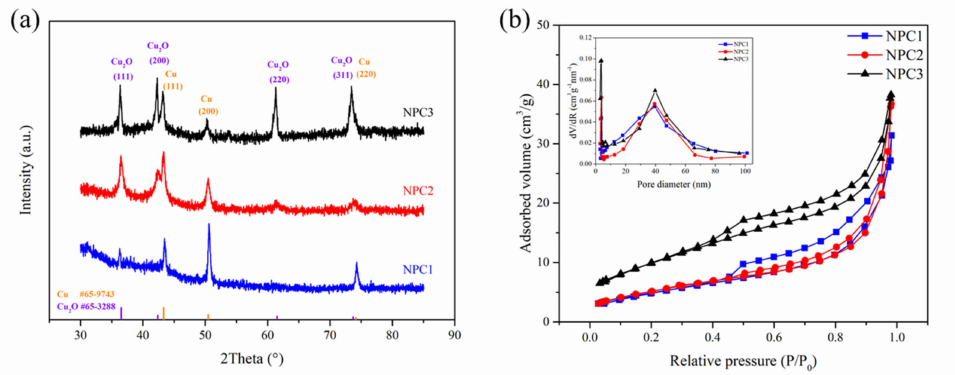
Figure 2. XRD patterns of the NPC1, NPC2, and NPC3 catalysts ( a ); N2 adsorption/desorption isotherms of the three catalysts, insert: the corresponding pore size distribution ( b